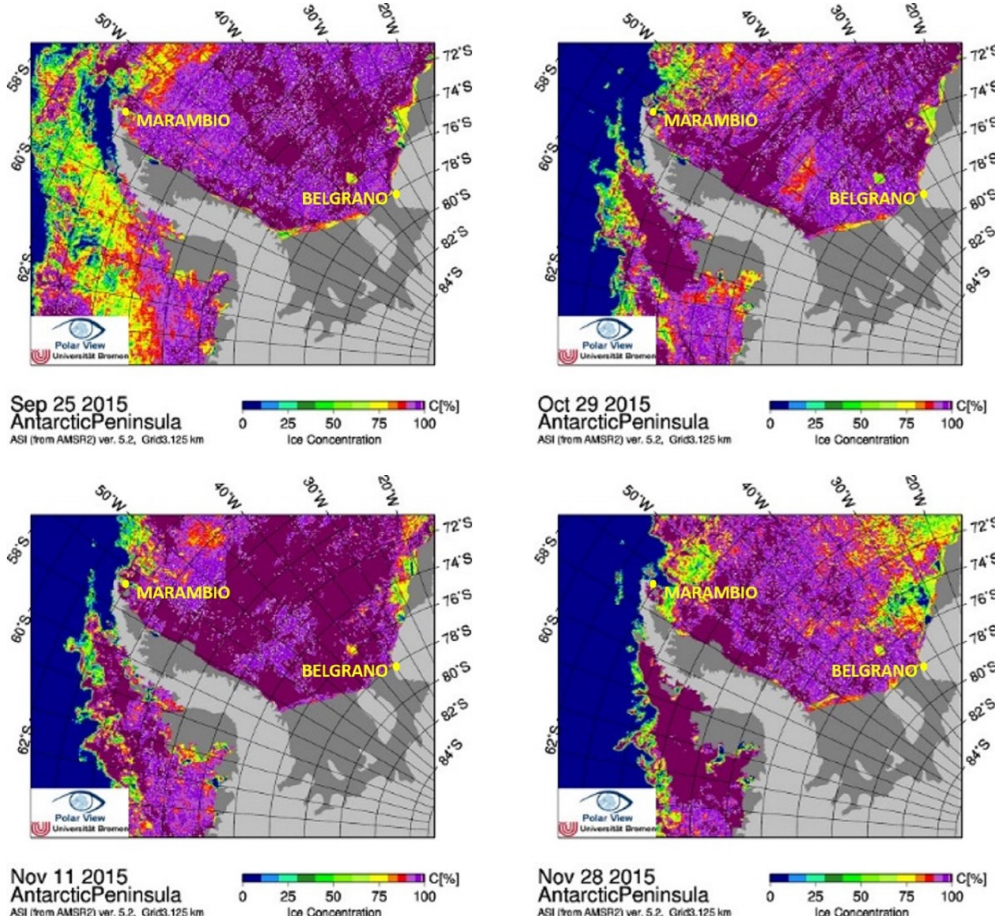
Figure 9. Sea ice conditions around the measurement sites during the exemplary days shown in Fig. 8. The maps of the sea ice concentration are downloaded from https://seaice.uni-bremen.de/databrowser/ (last access: 18 May 2018) (Spreen et al., 2008) and are sorted based on the date. The stations of Marambio and Belgrano are marked in yellow in the figures. As can be seen in the figures, in barely 1 month (25 September–29 October) the sea ice surrounding Marambio underwent strong transformation, going from medium–highly concentrated sea ice after winter (upper left figure) with barely permanent open waters to pretty much open ocean (all the sea ice disappearing beyond 50 ◦ W). During the timeframe of that sea ice transformation, BrO VCD2km peaked at Marambio (Fig. 4). Also, note how the edge of the sea ice near Belgrano transforms towards summer (e.g., lower